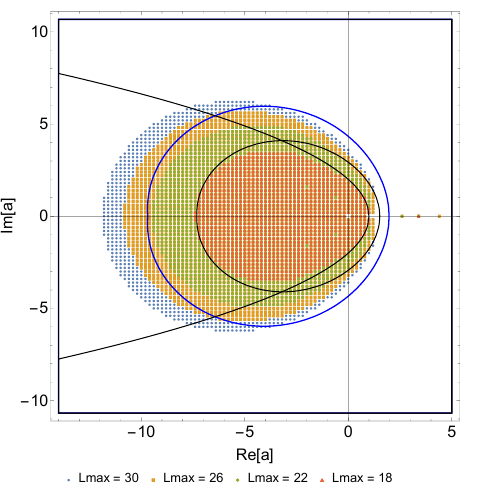
(c) Dyson block expansion of amplitude with k max = 40 . We consider s 1 = 23 / 3 , shown in blue contour and black lines are boundary of the overall domain.